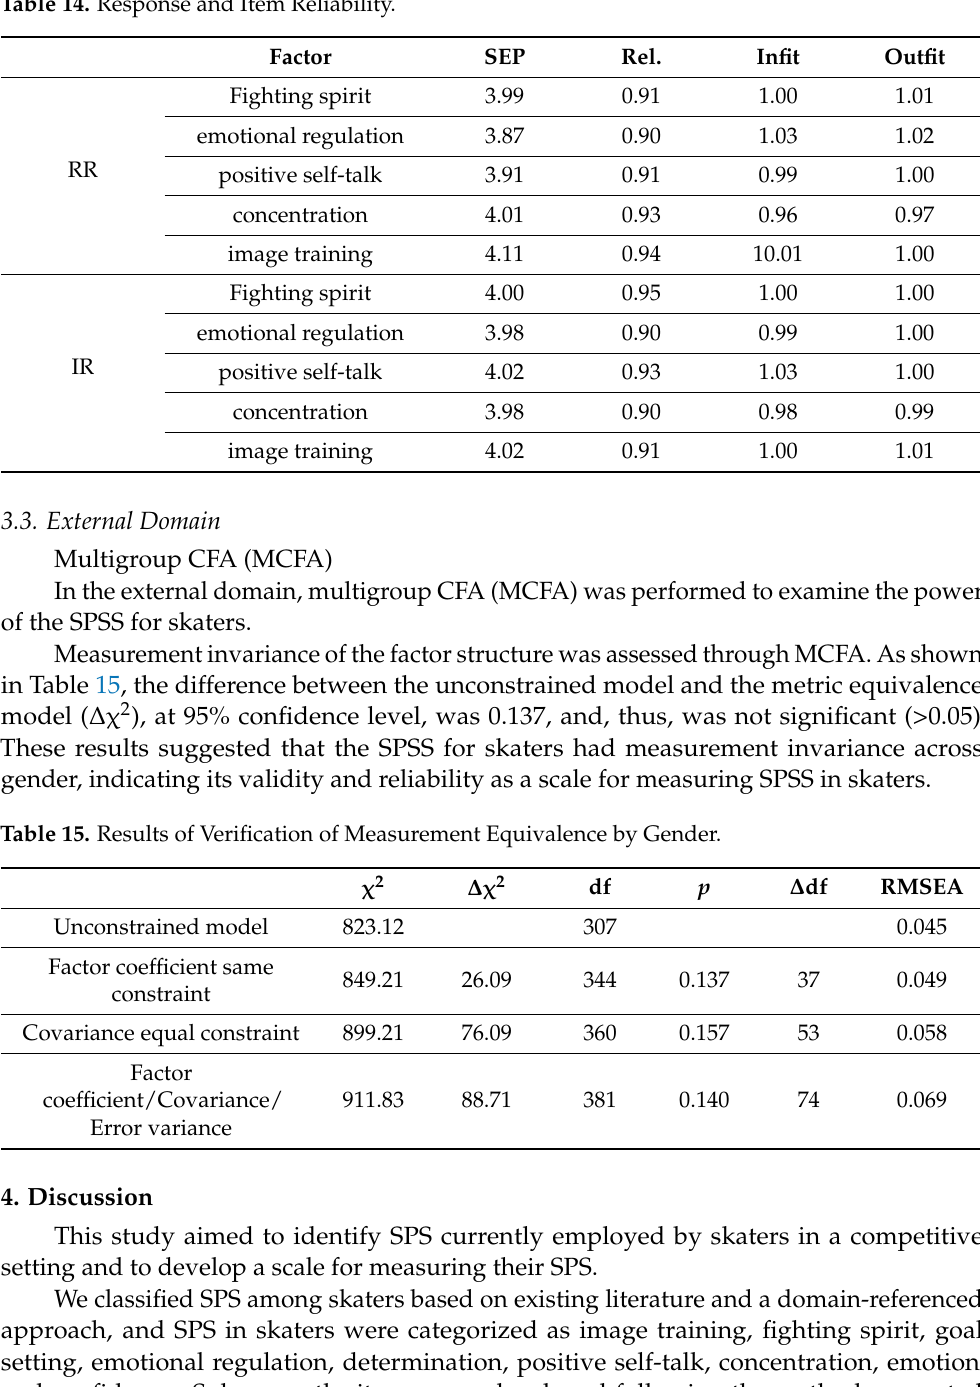
Table 14. Response and Item Reliability.